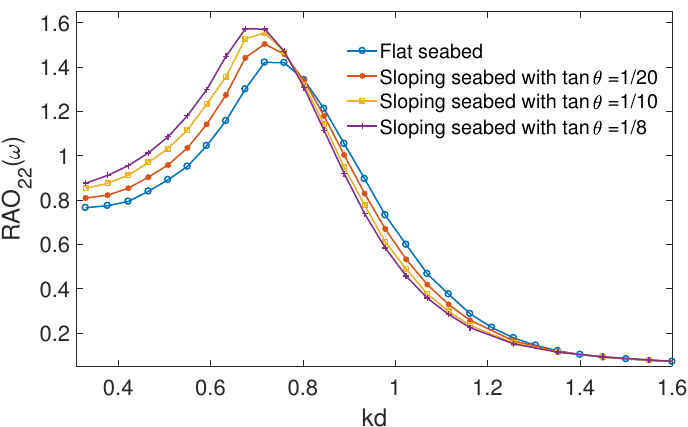
Figure 16. Comparison of the floating body heave motion RAO 22 ( ω ) between flat seabed, sloping seabed with tan θ = 1/20, tan θ = 1/10 and tan θ = 1/8, respectively with mooring line length L 1 = L 2 = 60 m.